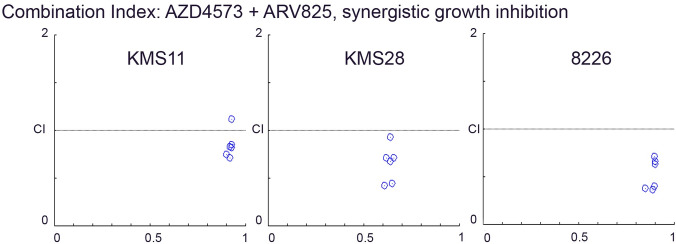
Combination index plot of ARV 825 with AZD 4573 against MM cells.Synergistic growth inhibition of KMS11, KMS28 and 8226 cells when ARV 825 and AZD 4573 are combined (72 h, MTT assay). CI < 1, CI = 1 and CI > 1 represent synergism, additive, and antagonism respectively of the combination of the two compounds. Values of Combination Index analysis are shown in S4 Table.